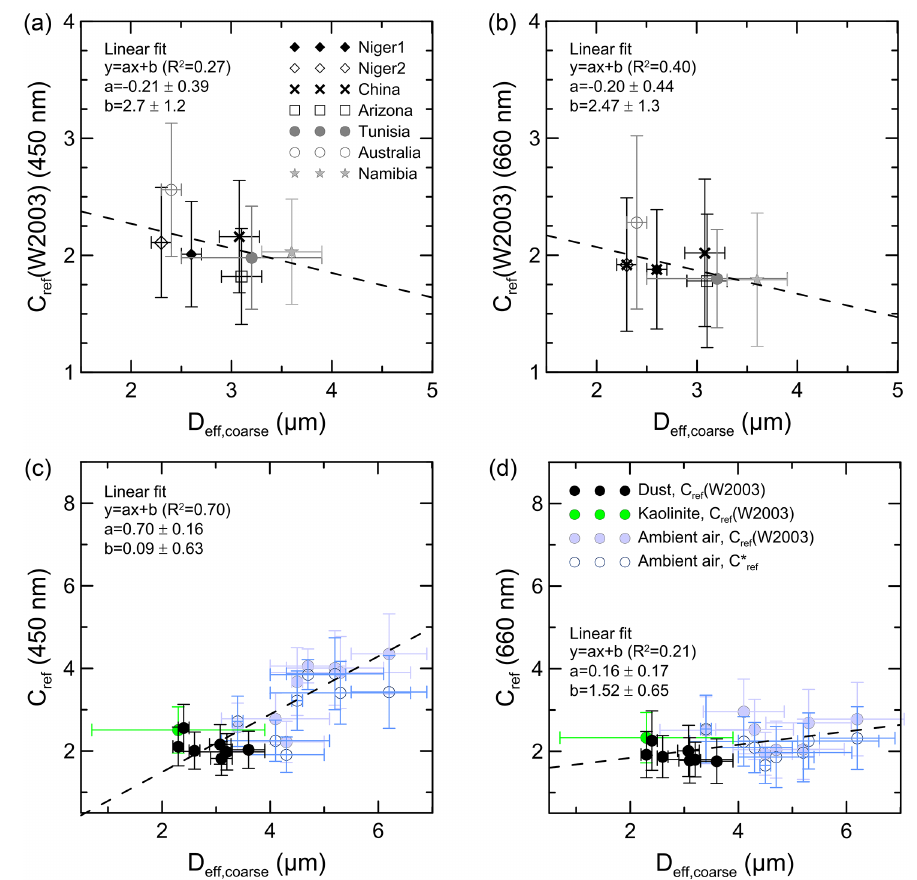
Figure 8. (a, b) C ref (W2003) (multiple scattering correction obtained by taking into account the loading effect correction using the parame- terizations by Weingartner et al., 2003) at 450 and 660nm versus the effective diameter coarse D eff , coarse . for mineral dust samples analysed in this study. Different symbols are used to distinguish between dust from different sources. The uncertainty of D eff , coarse is the standard deviation over 2min data, while that of C ref (W2003) is calculated with the error propagation formula taking into account the uncertainty of β abs , ref and that of β ATT /R (W2003). (c, d) C ref at 450 and 660nm versus the effective diameter coarse D eff , coarse for the different aerosol samples analysed in this study. Different symbols are used to distinguish between different aerosol types. Data for both C ref (W2003) and C ∗ (multiple scattering correction obtained while not taking into account the loading effect correction in Aethalometer data) are shown for ref ambient air aerosols, while for dust and kaolinite, for which the difference between the different formulations is very low, only C ref (W2003) is reported. The results of the linear fits between C ref and D eff , coarse for mineral dust and for the entire data set are also shown in the